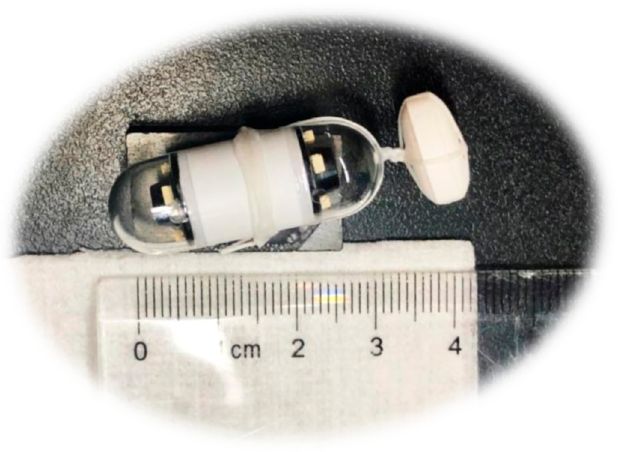
Figure 1. A dosage form is fixed in front of the camera capsule with a soft string (dental floss).